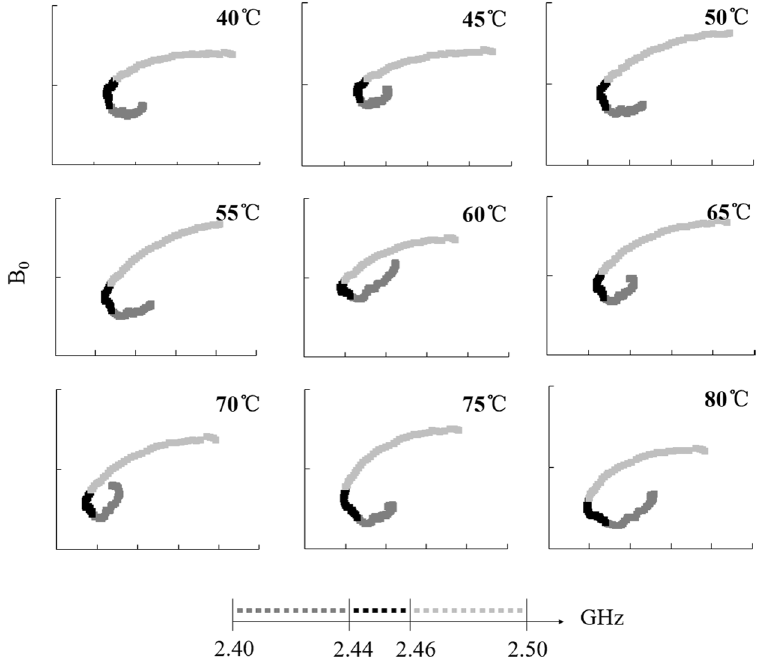
Figure 6. Change curve of starch–water mixtures B 0 ( = ε″ f B / ) varying with ε′ with microwave 0 If the starch suspension is placed in a microwave field, the charged particles can change their distribution state because of action of the electromagnetic field force. From a macro-perspective, changes in the system’s polar- was observed in the short interval 2.40–2.44 GHz with small geometric changes. Large geometric changes were observed in the long 2.46–2.50 GHz interval. A turning point was observed at 2.45 ± 0.01 GHz; there were two fit-